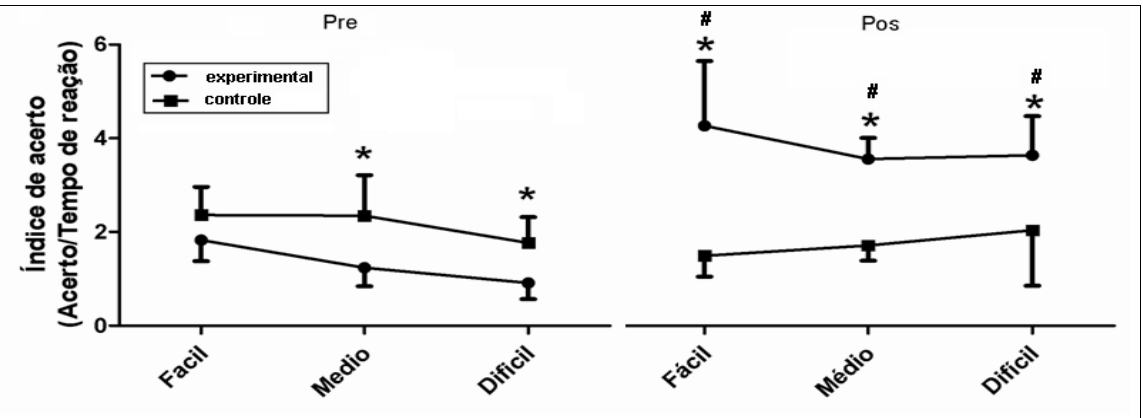
Figura 2. Índice de acerto (Acerto/Tempo de reação). A figura ilustra o Índice de acerto que é obtido através da divisão do Acerto pelo Tempo de reação, nos grupos experimental e controle. (*) Indica diferença entre o grupo experimental e controle, p<0.05. (#) Indica diferença do grupo experimental nos momentos pré e pós, p<0.05. Dados expostos na forma de média + DP